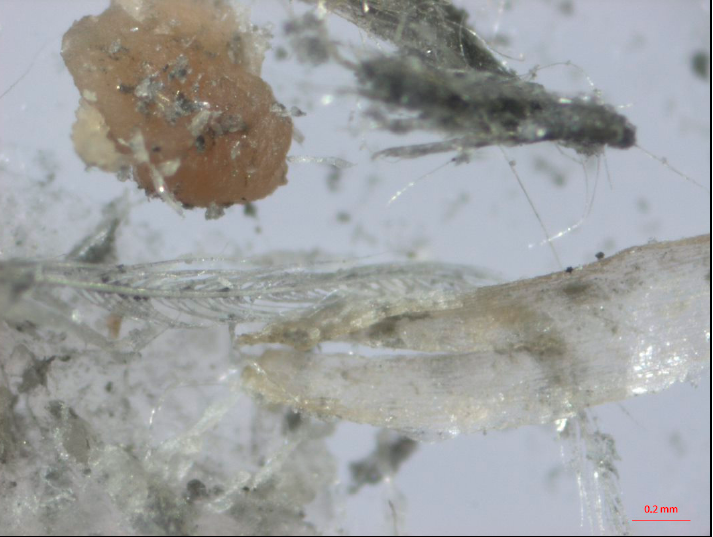
Figure 2. The microscopic view of the grease. 191